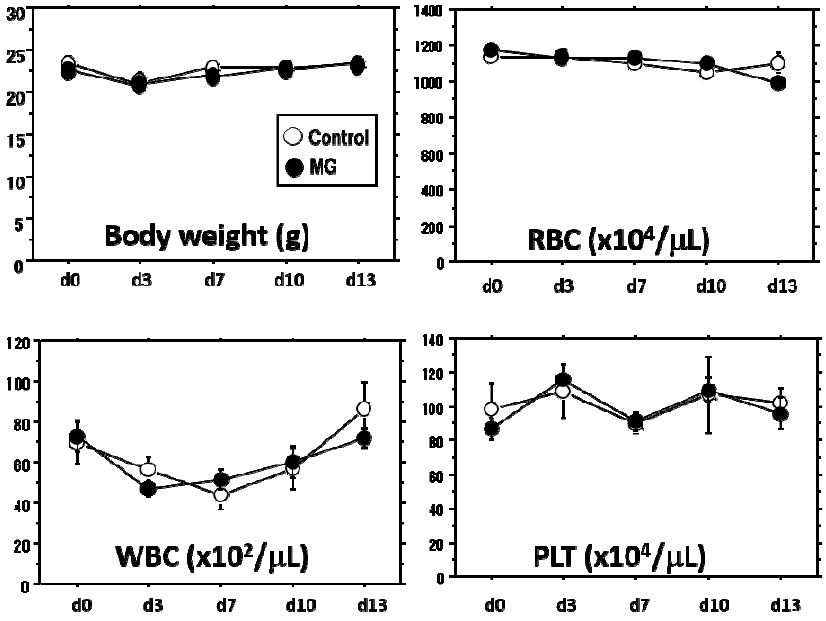
Figure 4. Physiological data after micrograft. The wound healing study with micrograft was performed for 13 days. Physiological monitoring (body weight) and hematological monitoring (WBC, RBC and PLT counts) were conducted. No differences were found between the MG and control groups. Tissue alterations especially for epithelial healing were investigated using our morphometric method previously established. Epithelialization was doubly progressed in the MG group compared with the saline control (Figure 5B); in which epidermal regenerative healing was significantly prominent in the MG group (about three-times greater than that of the